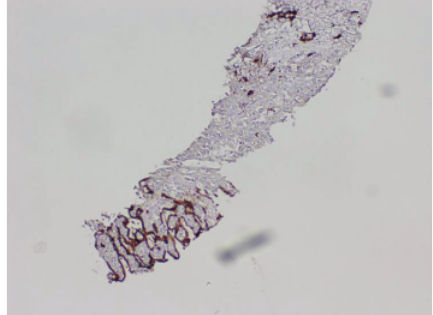
Figure 1: MRI of the abdomen with contrast shows multiple lesions in the right and left liver lobes, the largest 8.5 cm.